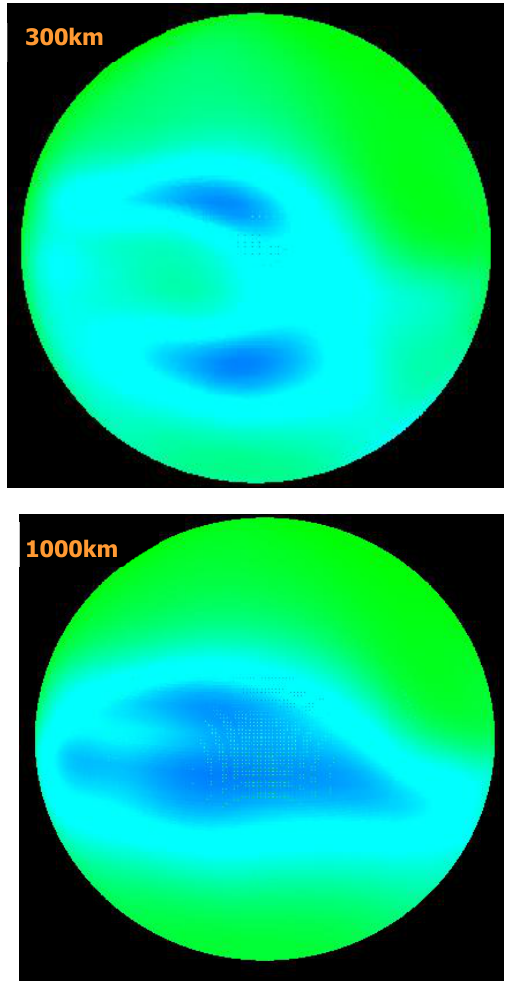
Figure 6. Visualization analysis of the ionospheric electron density in different altitudes